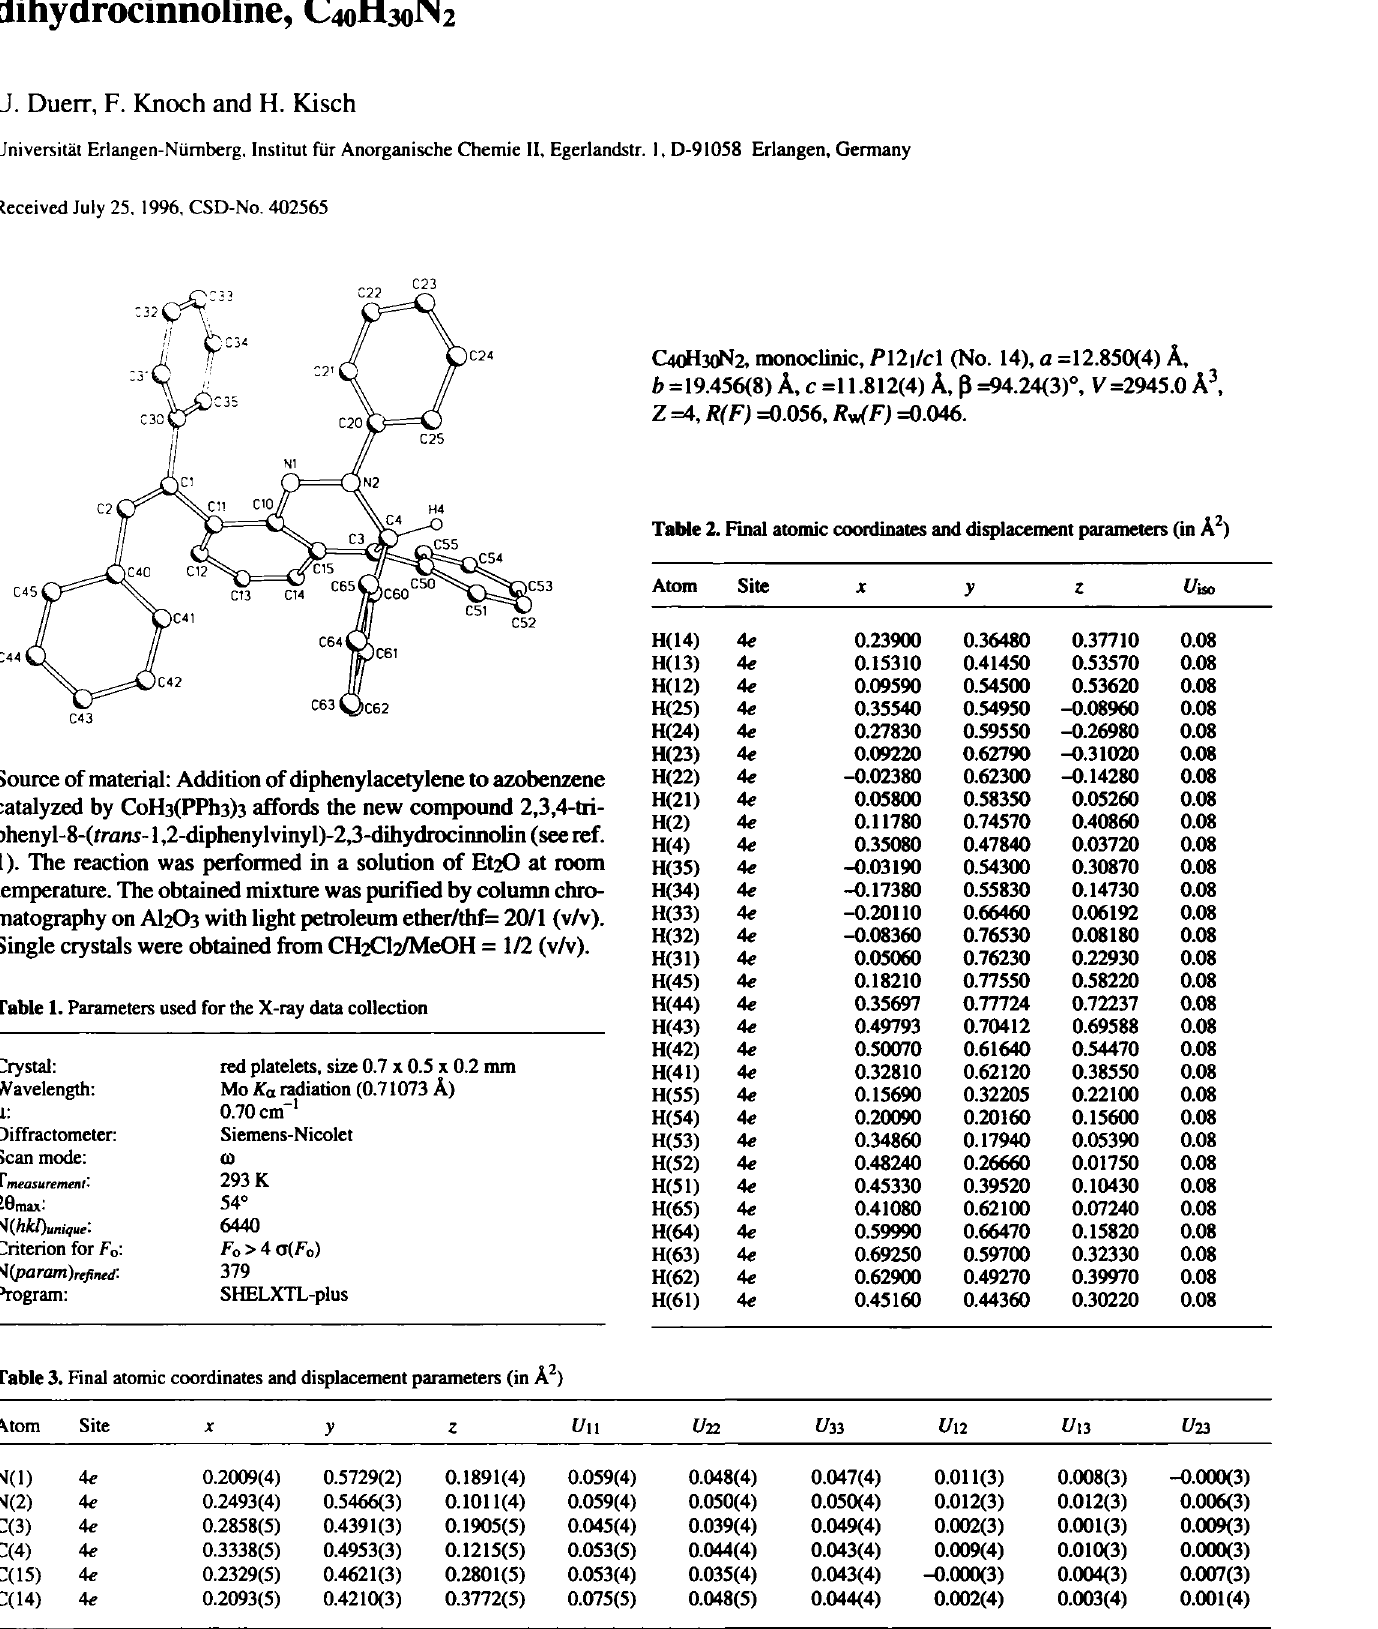
Table 2. Final atomic coordinates and displacement parameters (in Â 2 )